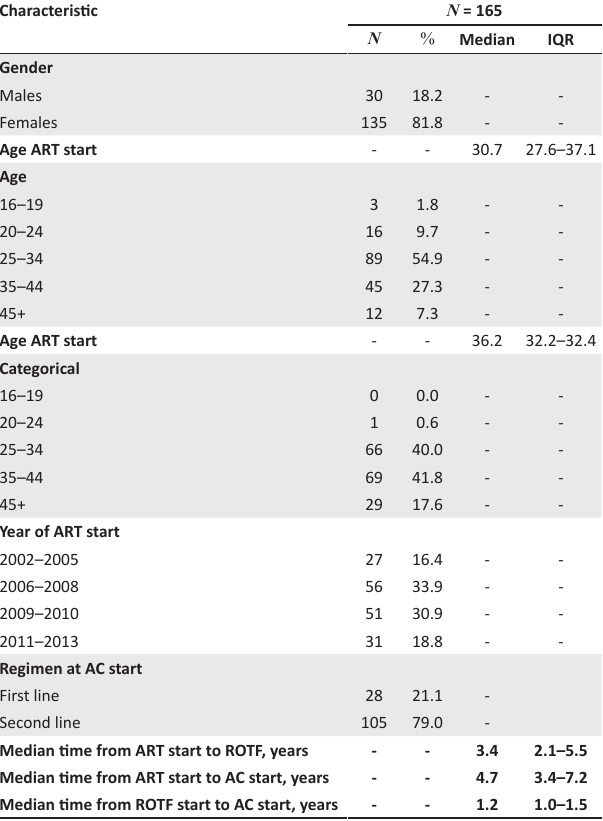
TABLE 1: Description of risk of treatment failure patients who suppressed and were referred to an adherence club. Characteristic N = 165